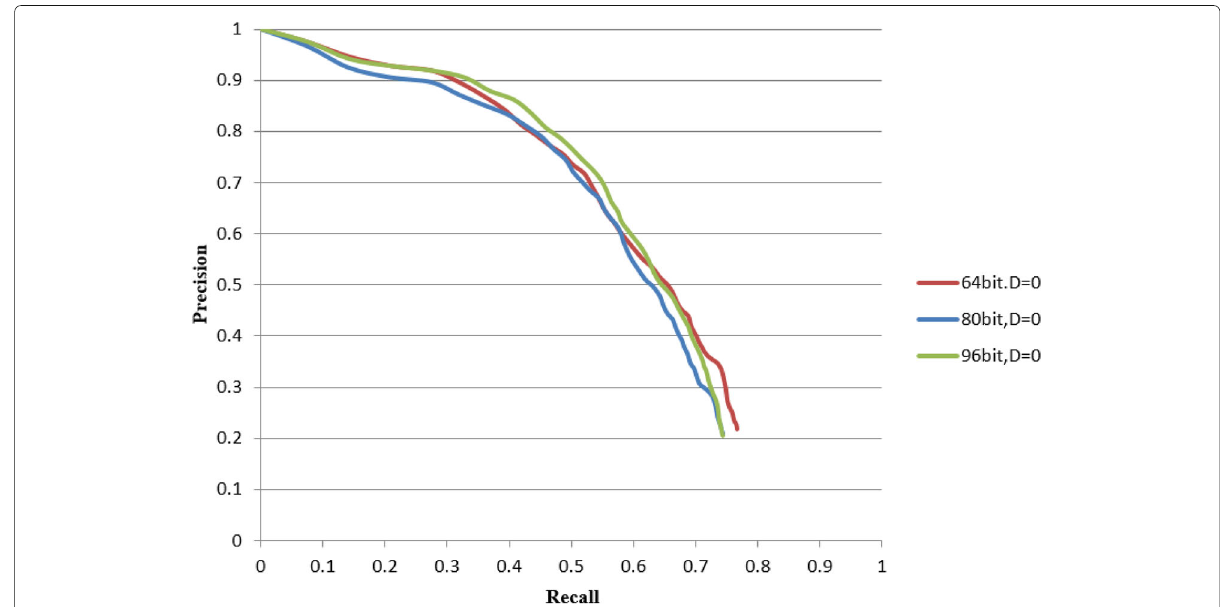
Fig. 7 Performance using hash codes of different lengths